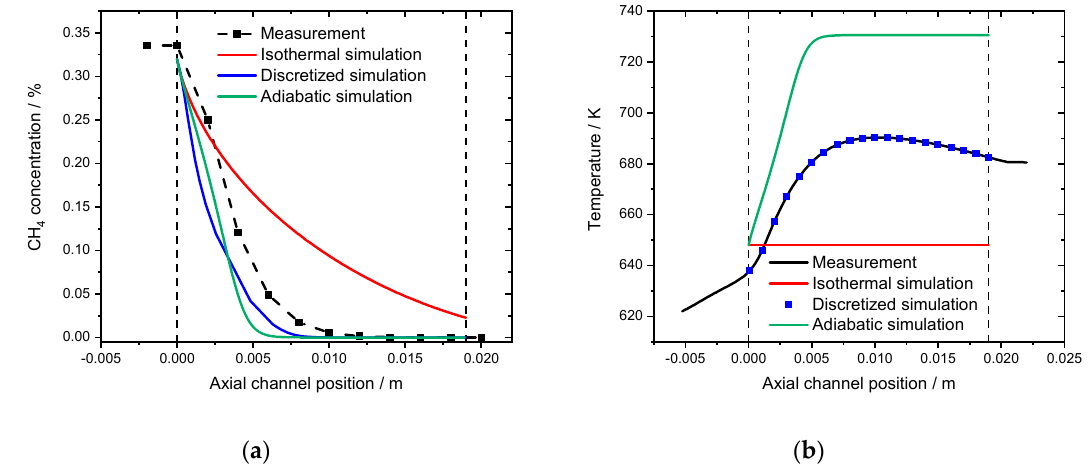
Figure 10. ( a ) Spatially resolved concentration profile at an inlet temperature of 648 K for the measurement (black line), the isothermal model (red line), the discretized simulation using the experimentally measured temperature profile (blue line) and the adiabatic simulation (green line) for 3200 ppm CH 4 , 10% O 2 in N 2 . The dashed lines (0 and 19 mm) indicate the monoliths length. ( b ) Associated spatially resolved temperature profiles for the experimentally measured (black line), the simulated adiabatic profile (red line) in comparison to the isothermal simulation (blue line) for the measurement in absence of water at an inlet temperature of 648 K. GHSV = 30,000 h − 1 .